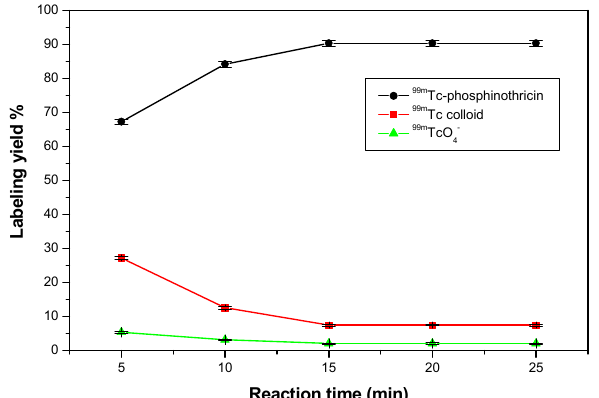
Figure 11. Radiochemical yield of 99m Tc-phosphinothricin as a function of reaction time. Reaction conditions: 1.5 mg of phosphinothricin, 10 µg SnCl 2 ·2H 2 O, and 100 µL (7.2 MBq) of 99m TcO 4 − solution, at pH of 8.